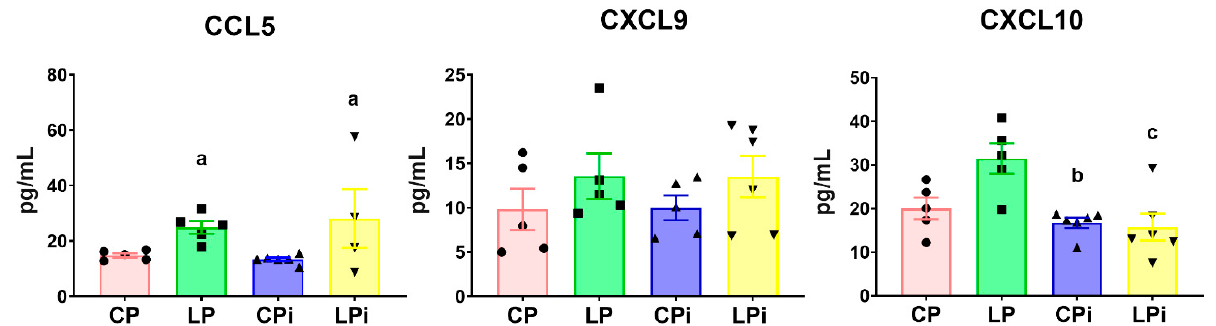
Figure 8 . Chemokine levels in the luminal fluid of duodenum from malnourished BALB/c mice infected with L. infantum . CCL5, CXCL9, and CXCL10 levels in the luminal fluid of duodena were measured at 14 days post-infection using a flow cytometry-based multiplex assay. Significant differences due to diet (a), p < 0.05; significant differences due to infection (b), p < 0.01; significant differences due to interaction between diet and infection (c), p < 0.05, as determined by two-way ANOVA. CP: animals fed 14% protein diet; LP: animals fed 4% protein diet; CPi: animals fed 14% protein diet and infected; LPi: animals fed 4% protein diet and infected.